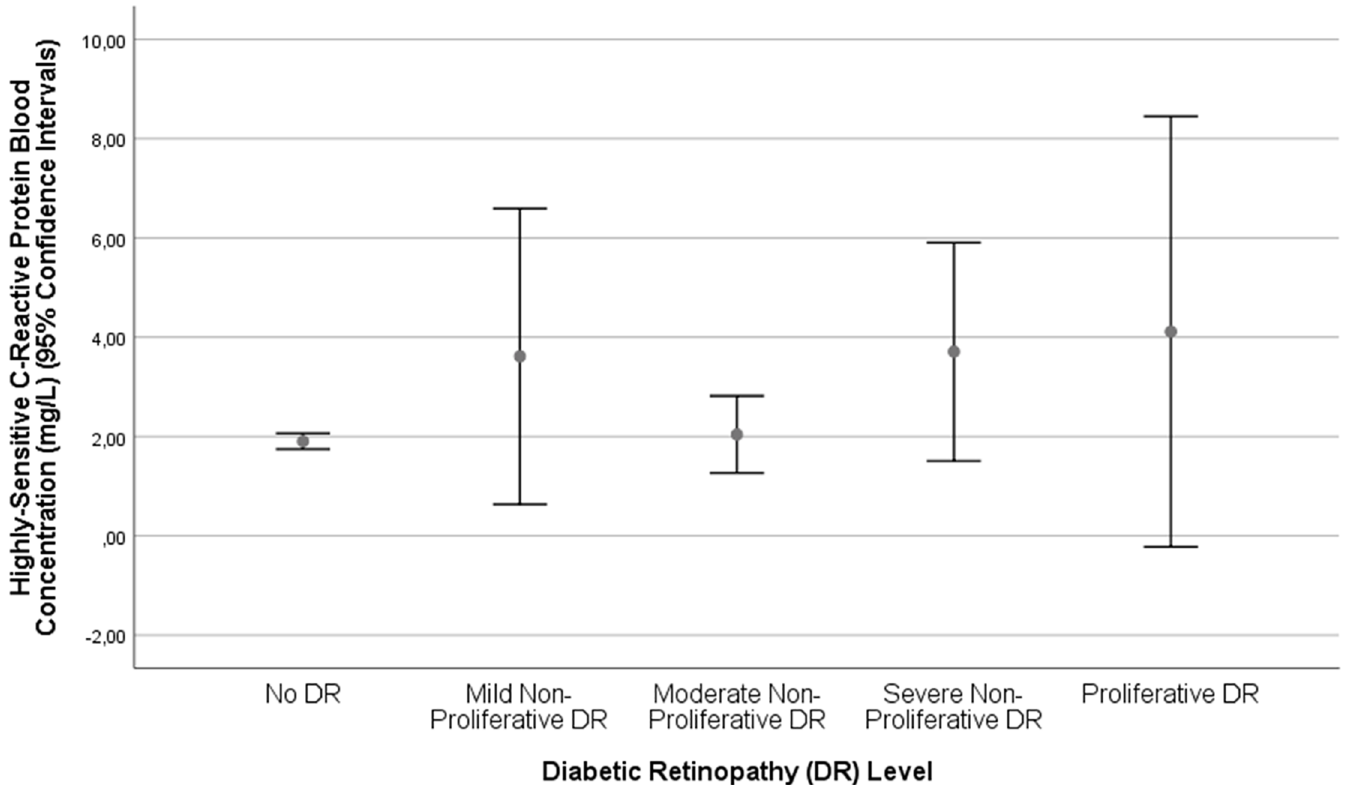
Fig 2. Graph showing the distribution of hs-C-reactive protein in the Beijing Eye Study, stratified by the stage of diabetic retinopathy.